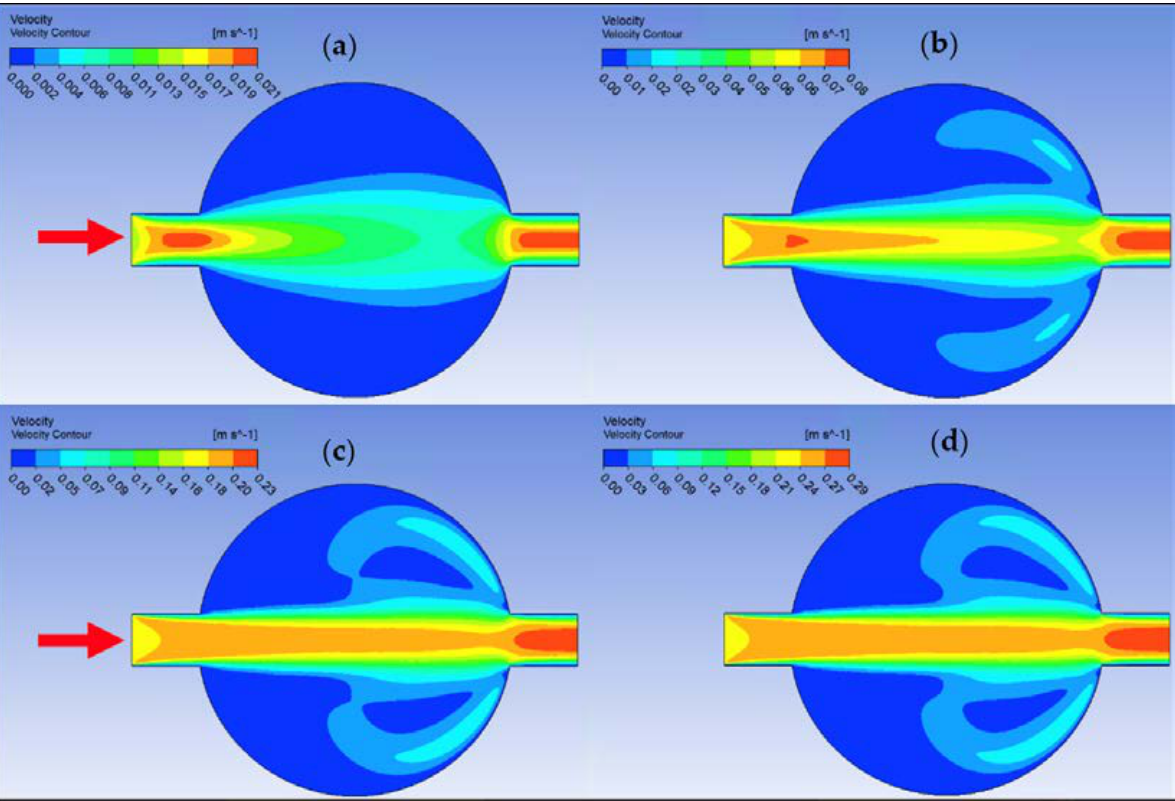
Figure 17. Velocity contour for deionized water in spherical connector. ( a ) Re = 25, ( b ) Re = 100, ( c ) Re = 300, and ( d ) Re = 400.